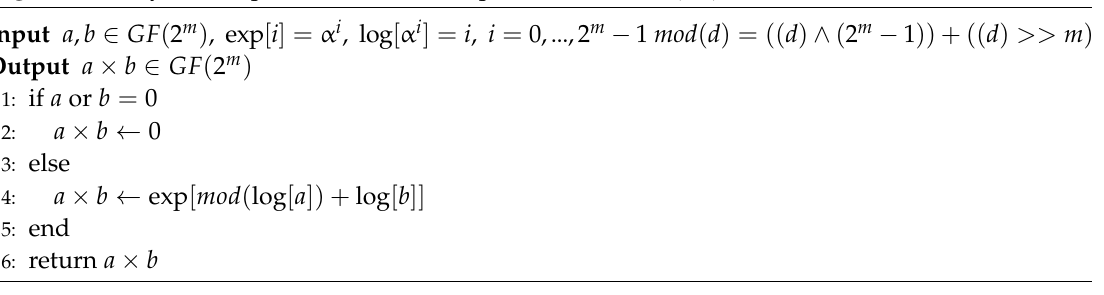
Algorithm 8 HyMES implementation : Multiplication over GF ( 2 m ) [6]